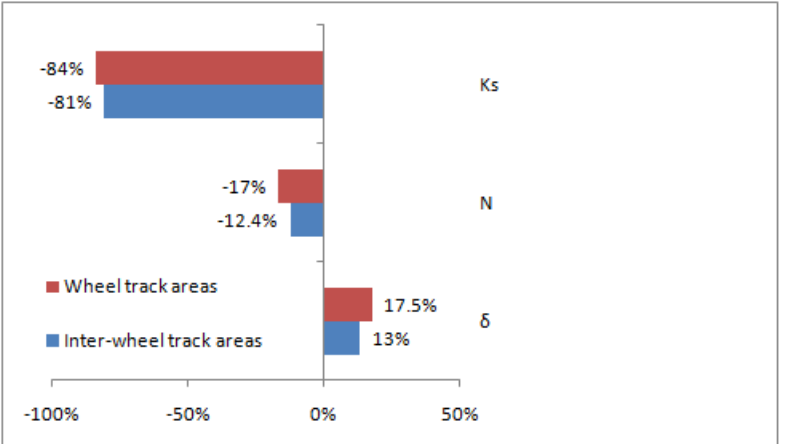
Figure 3: Relative variation (%) of Saturated Hydraulic Conductivity, Porosity and Bulk Density: before and after tillage and machinery work. Ks= Saturated Hydraulic Conductivity, P=Total Porosity, δ=Bulk